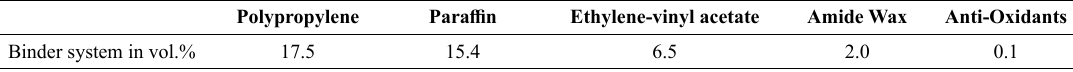
Table 2. Binder system used in the powder injection molded samples. Polypropylene Paraffin Ethylene-vinyl acetate Amide Wax Binder system in